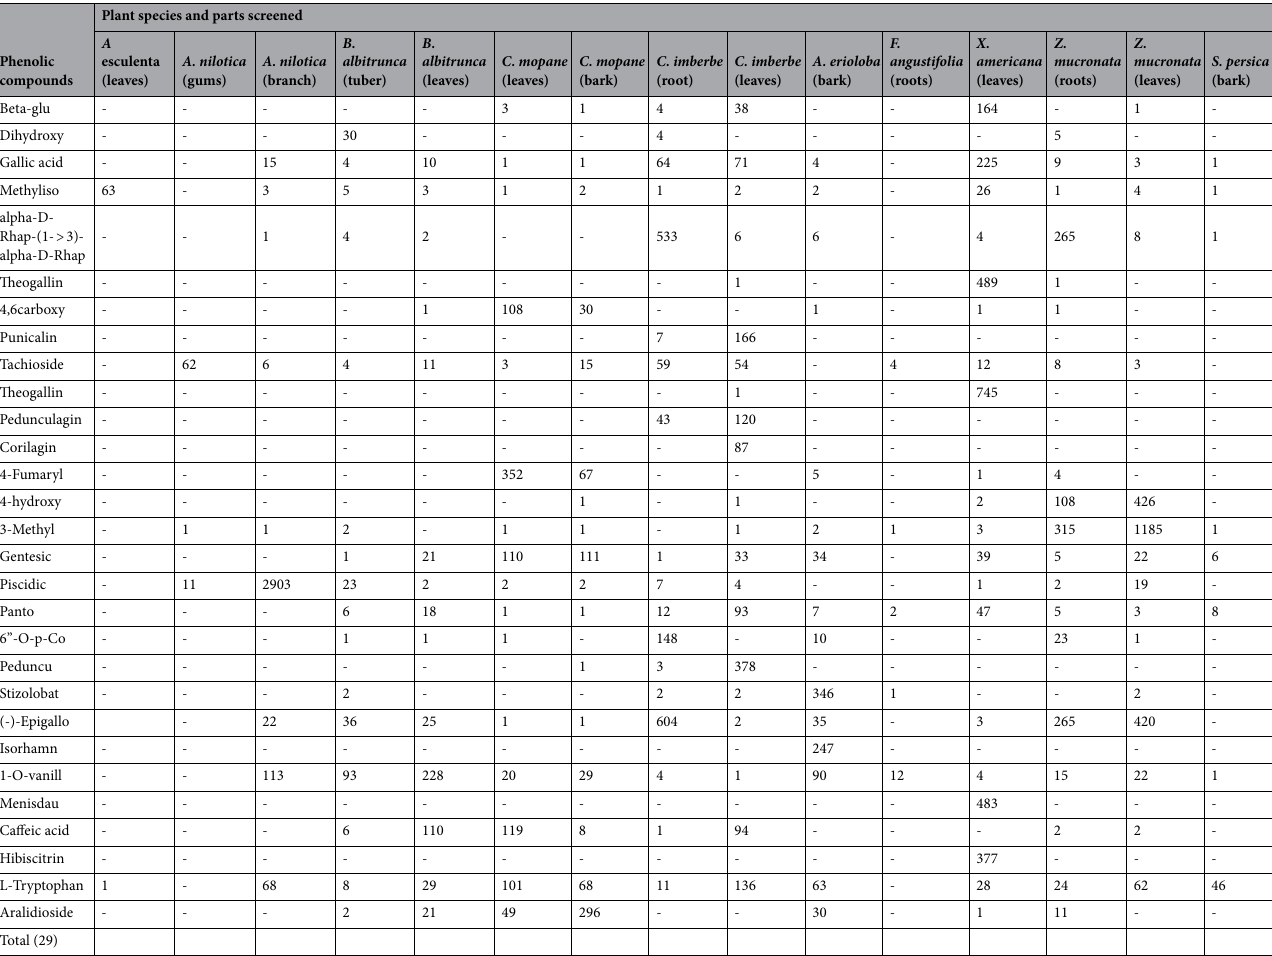
Table 2. Phenolic compounds detected in the examined species. (-) = Absence. Beta-Glu; dihydrox; 6- {[2-(3,4-dihydroxyphenyl, Methyliso; Methylisocitric acid, Rhap-(1- > 3); alpha-D-Rhap-(1- > 3)-alpha-